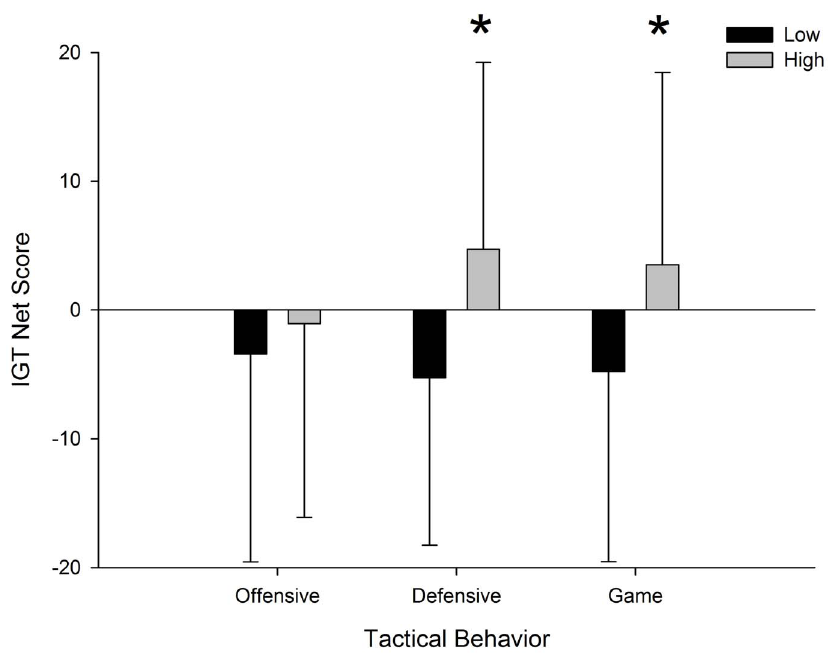
Figure 1. Comparison of the performance of players from low and high tactical behavior groups on IGT net score.